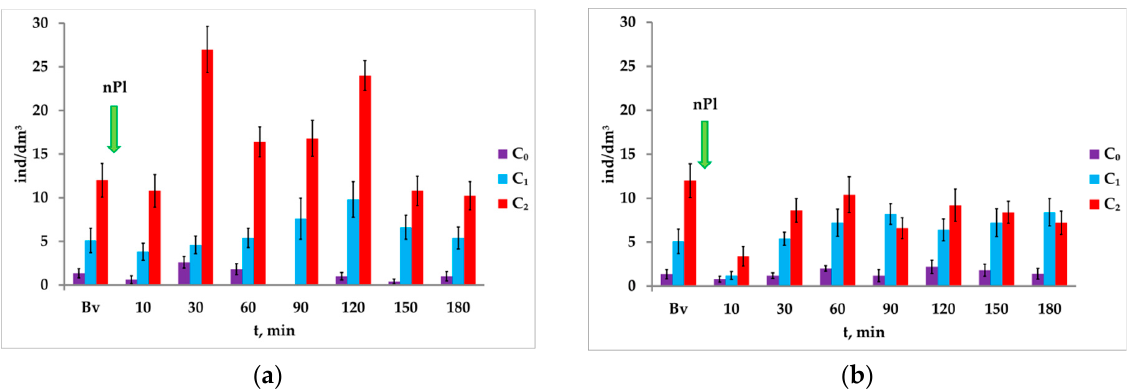
Figure 6. Response of A. salina to paired photostimulation in the presence of nanoplastics at the concentration of 0.1 mg/dm 3 ( a ), 1.0 mg/dm 3 ( b ). C 0 —average concentration of crustaceans before photostimulation; C 1 —average concentration of crustaceans at photostimulation with intensity I 1 (1150 lx); C 2 —average concentration of crustaceans at photostimulation with intensity I 2 (3450 lx); Bv—background value; Green arrow—pollution.